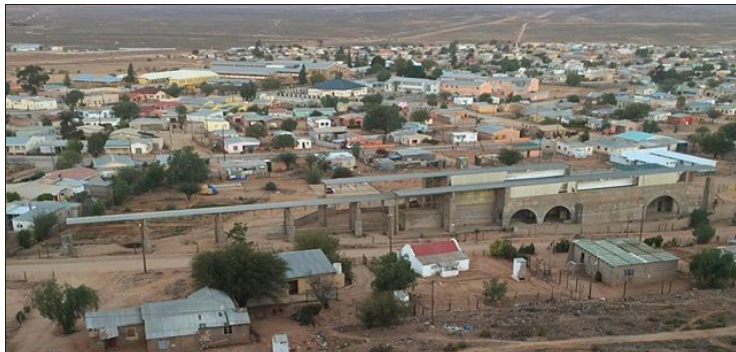
Figure 8: The context with the Steinkopf Community Centre in the foreground and another community centre in the